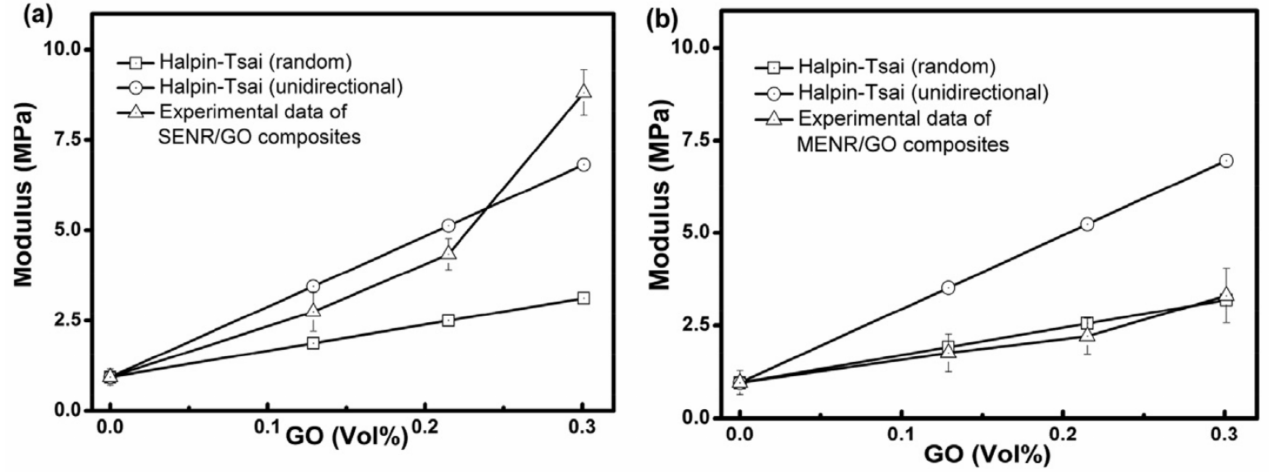
Figure 38. Experimental data of Young’s modulus (M200) and HalpineTsai theoretical model fitting for: ( a ) SENR/GO nanocomposites and ( b ) MENR/GO nanocomposites